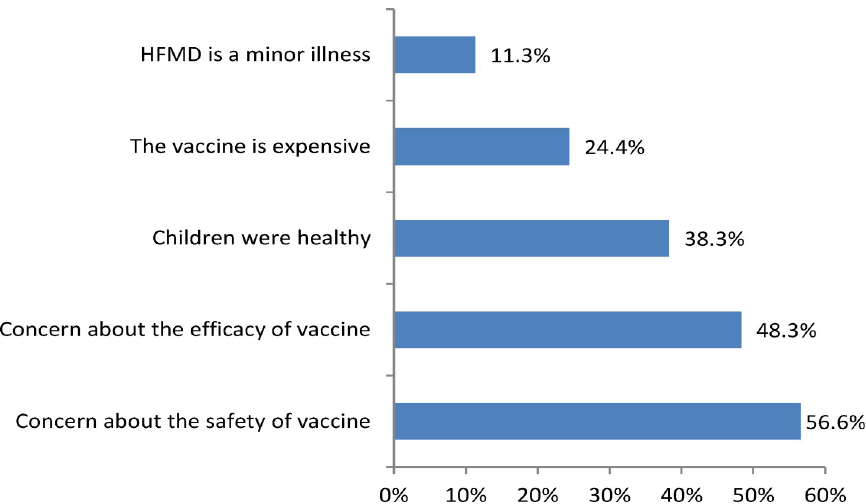
Fig 3. Participants’ reasons for declining EV71 vaccination. The blue columns indicate the proportions of possible reasons for declining EV71 vaccination.